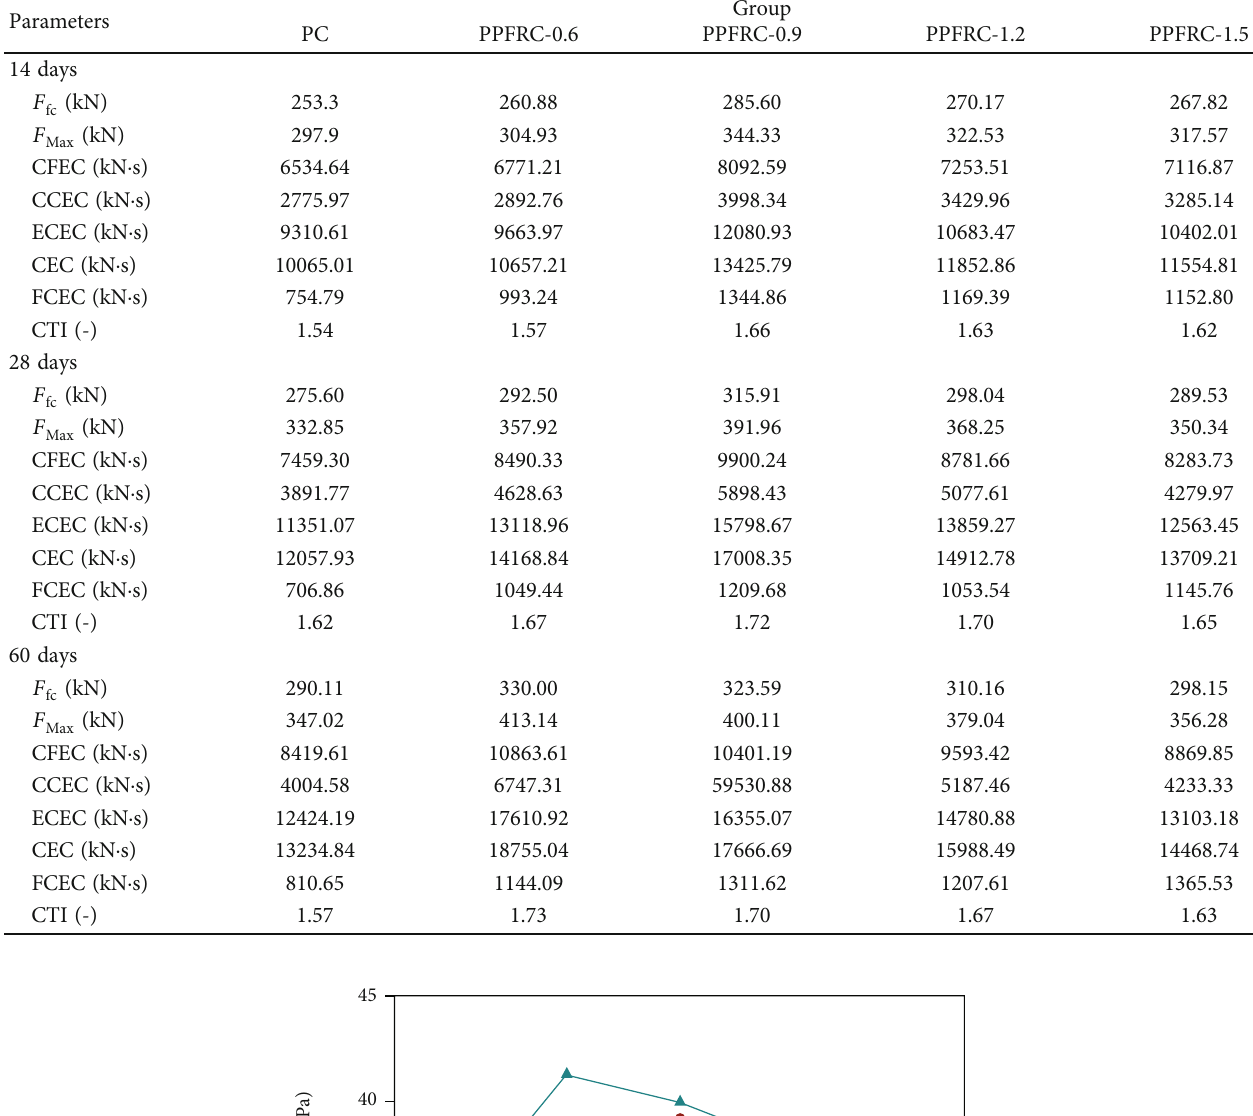
Table 6: The CFEC, CCEC, ECEC, CEC, FCEC, and CTI values of PC and PPFRC at 14, 28, and 60 days of curing.